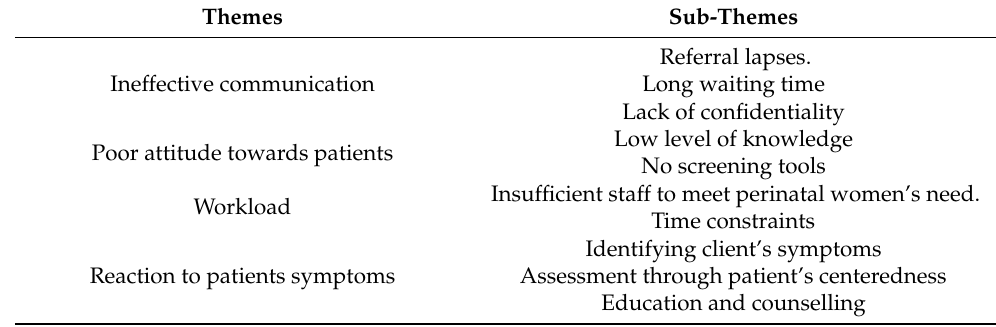
Table 1. Themes and